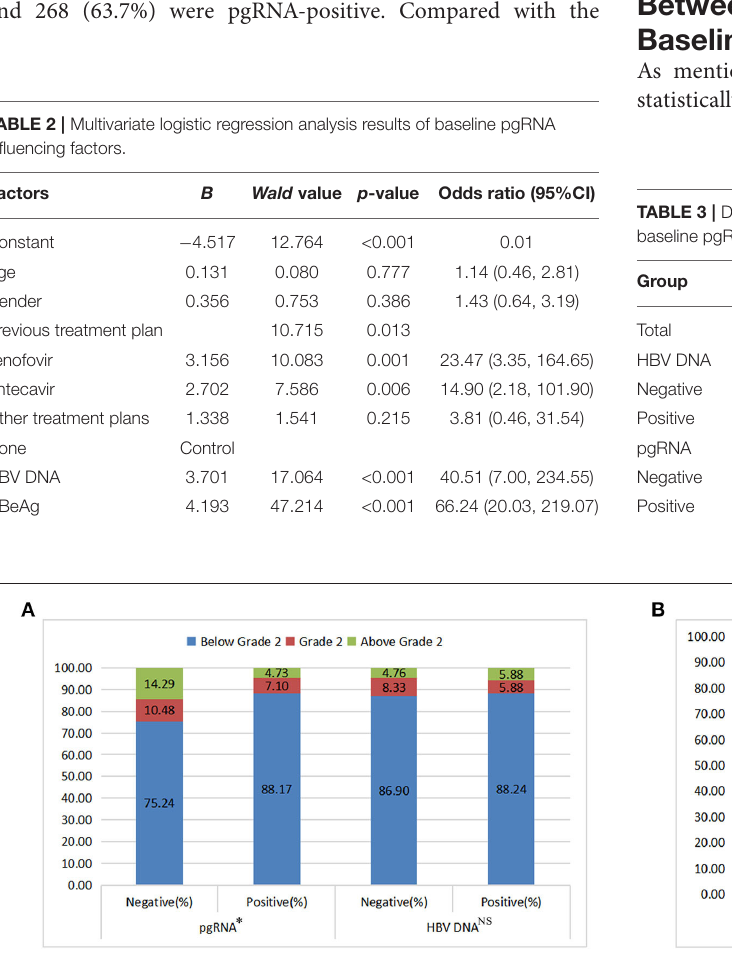
Frontiers in Public Health |